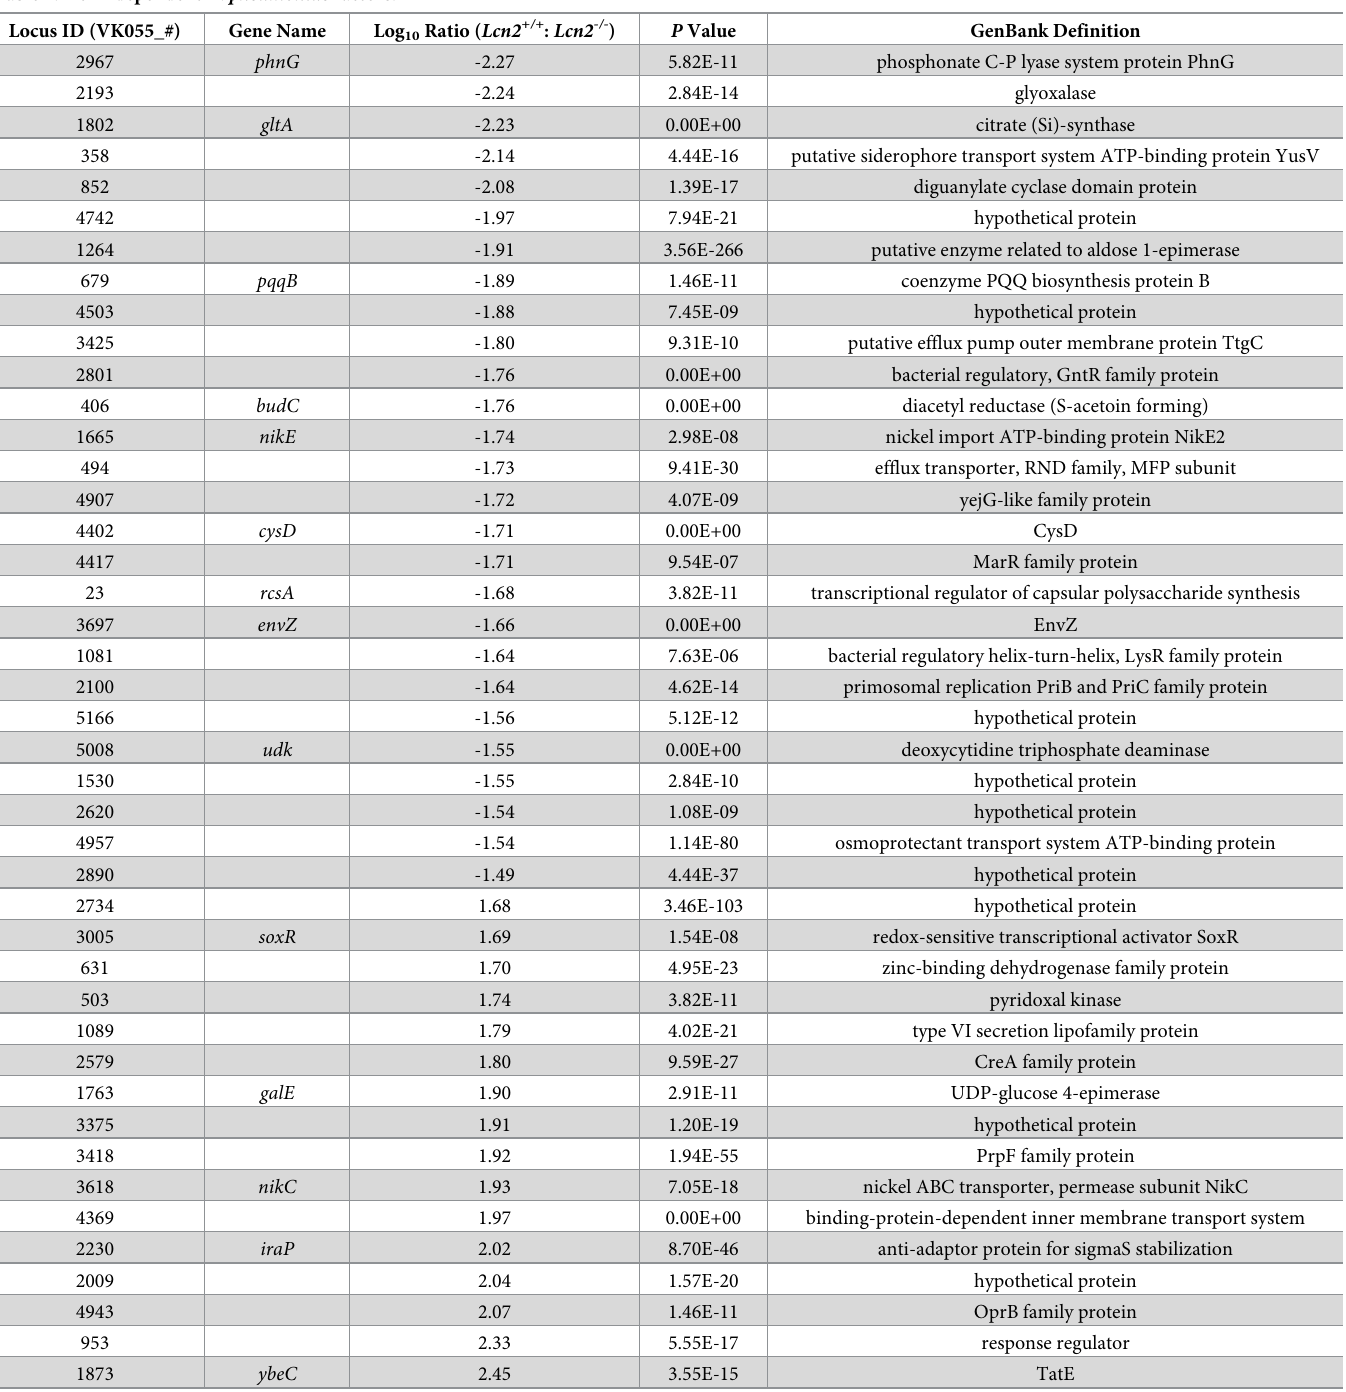
Table 1. Lcn2-dependent K . pneumoniae